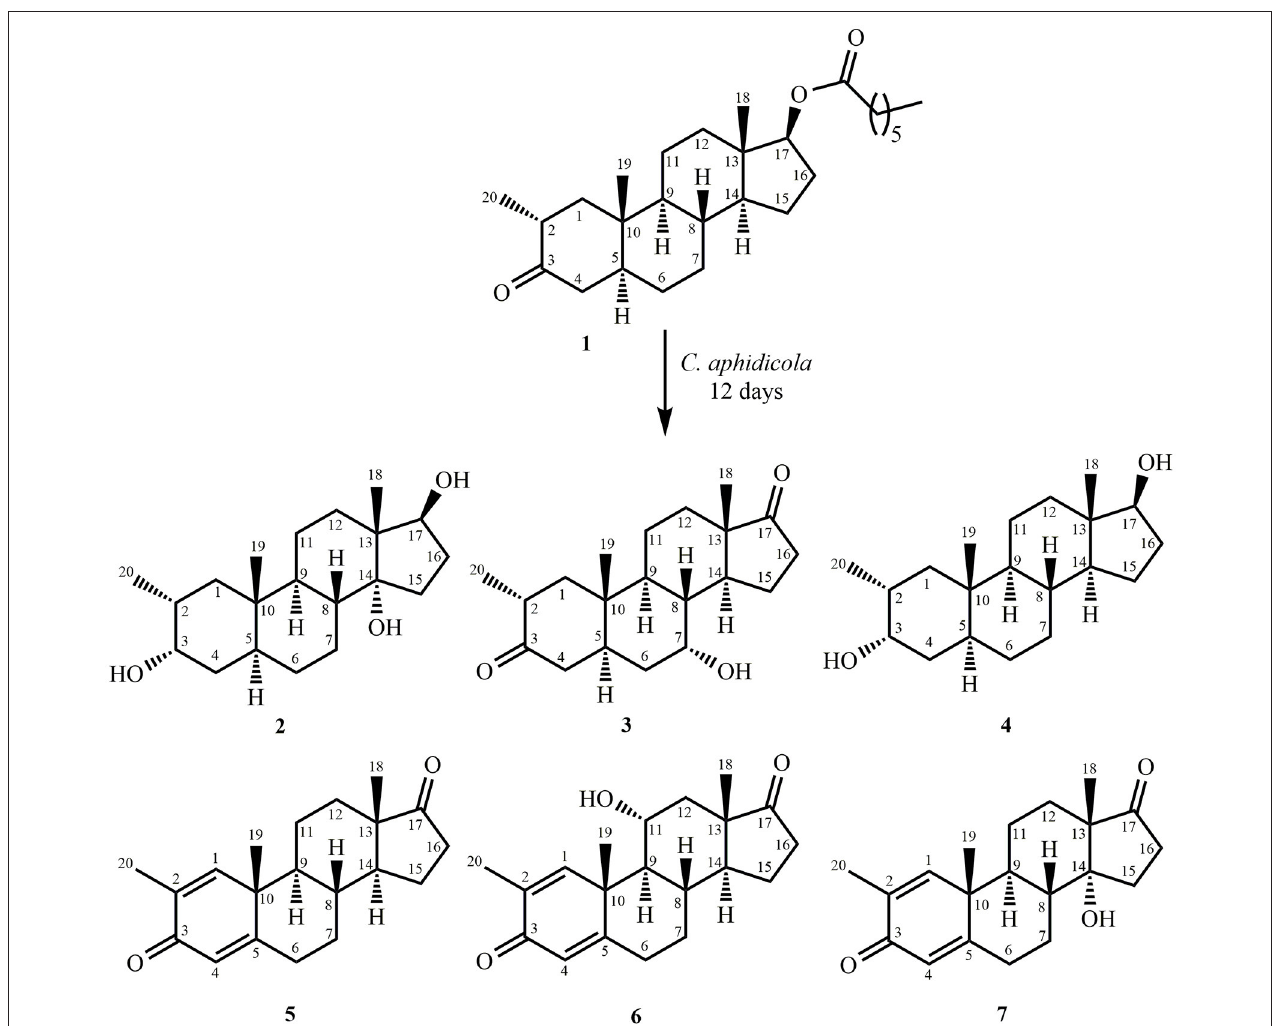
FIGURE 1 | Biotransformation of drostanolone enanthate ( 1 ) with Cephalosporium